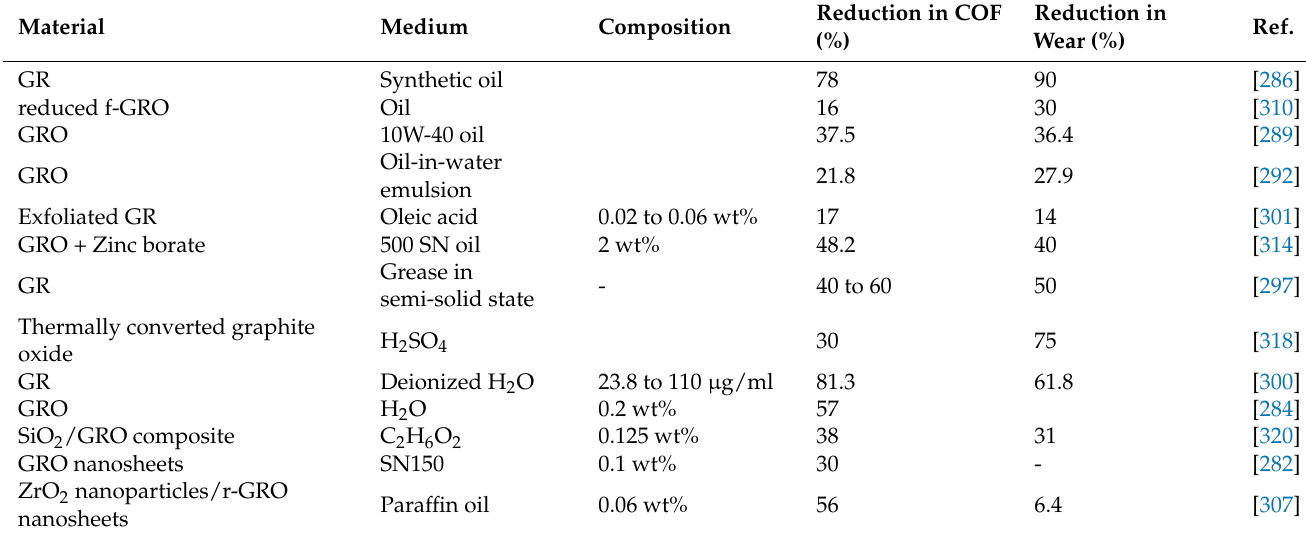
Table 7. Summary of improvements in tribological characteristics using GR based